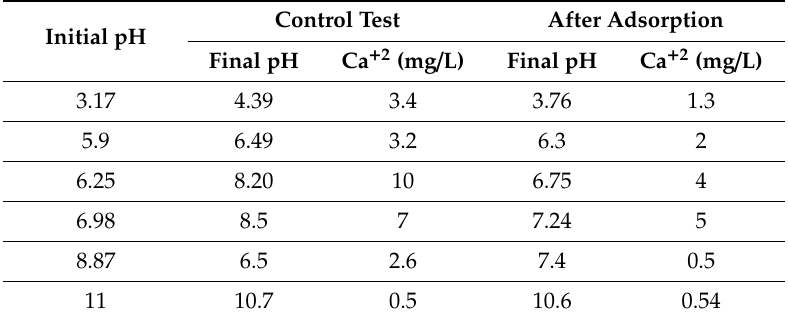
Table 5. The values of final pH and residual concentration of calcium after the sorption of benzaldehyde onto iron slag in comparison with the control